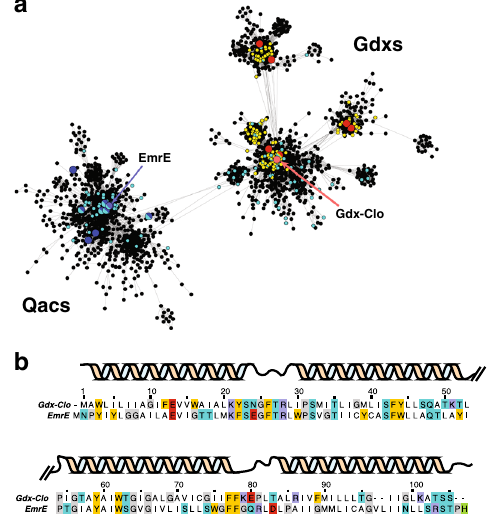
Fig. 1 Colocalization of SMR genes with guanidine riboswitches and horizontal gene transfer elements. a Major clusters (>10% of total set) from the sequence-similarity network of the SMR family. Each point corresponds to a cluster of sequences with >50% sequence identity. Edges between points correspond to a pairwise E value of at least 10 − 20 . Biochemically characterized proteins are shown as enlarged red (Gdx) or blue (Qac) points. SMR sequences associated with a guanidine riboswitch are colored in yellow. SMR sequences found on plasmids or genetically colocalized with integron/integrase sequences are colored cyan. Full sequence-similarity network shown in Supplementary Fig. 1. b Sequence alignment of EmrE and Gdx-Clo with positions of α -helices